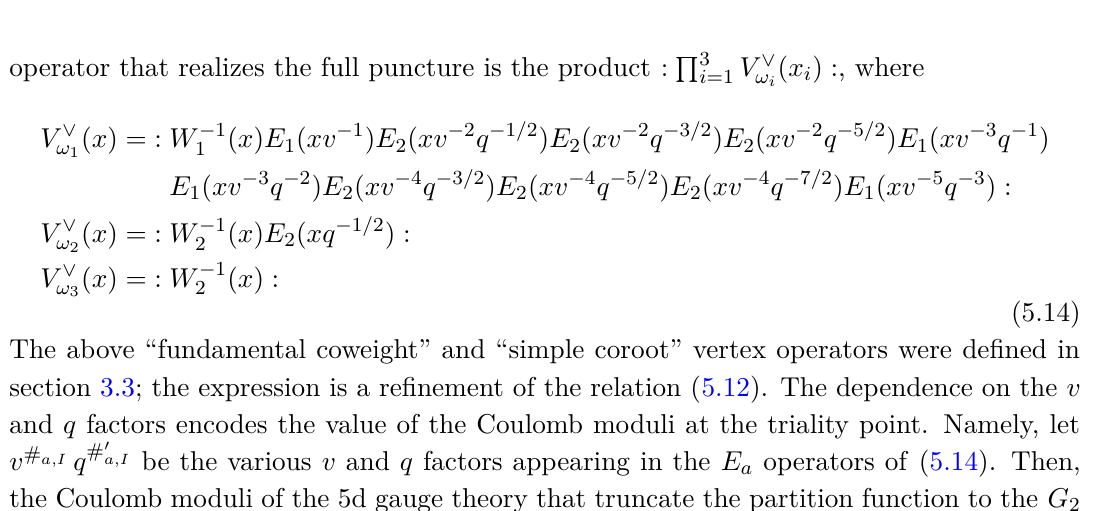
Figure 7. Sphere with 3 full G 2 punctures: 5d theory T 5d and 3d theory G 3d resulting from W S